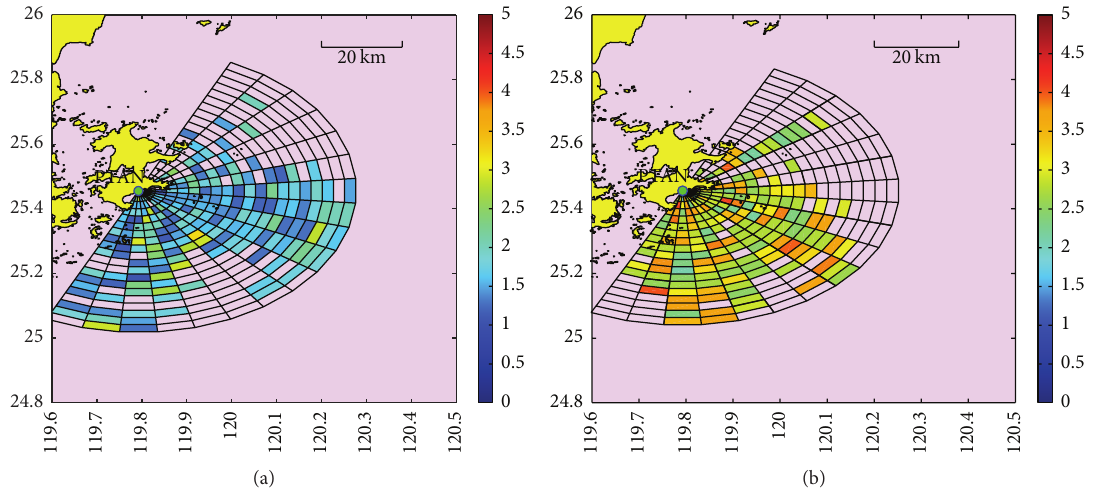
Figure 6: The wave maps after replacement. (a) 21:00 to 23:00 Sep 27, 2014; (b) 17:30 to 19:30 Oct 9, 2014.